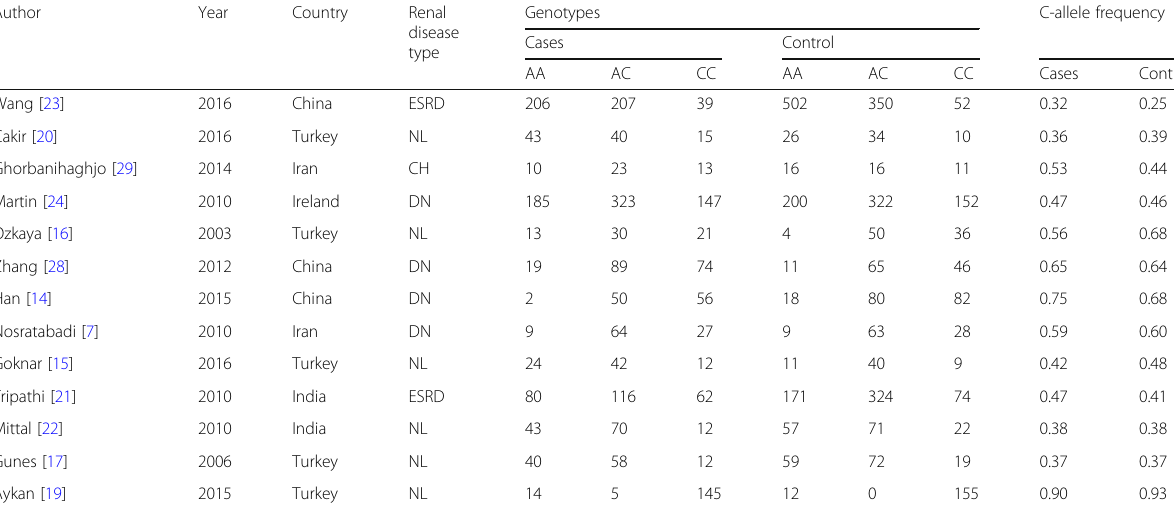
Table 3 Distribution of VDR1 ApaI polymorphism across different case-controls